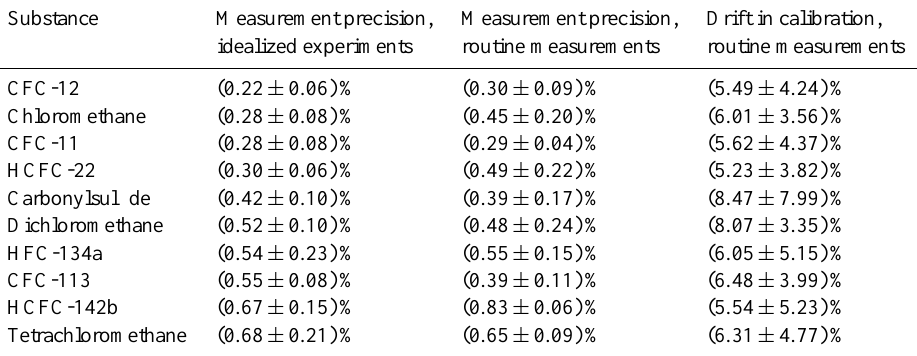
Table 6. Mean measurement precision and relative drift in calibration of 10 selected substances which were chosen according to a precision of generally better than 1%. Data are based on five different precision experiments using different reference gases and sample volumes from 0.49 to 1.38L as well as four routine measurement series including four to five samples per series. Precision values were calculated as the arithmetic mean of all sample blocks per measurement series. Drift calculated as minimum to maximum range of normalized chromatographic signal areas of calibration measurements within the routine measurement series (10–16h total duration). Errors are displayed as the 1-fold standard deviation over all values used per substance. All measurements were conducted with a TOFMS configuration giving an R of 3500 in mean.